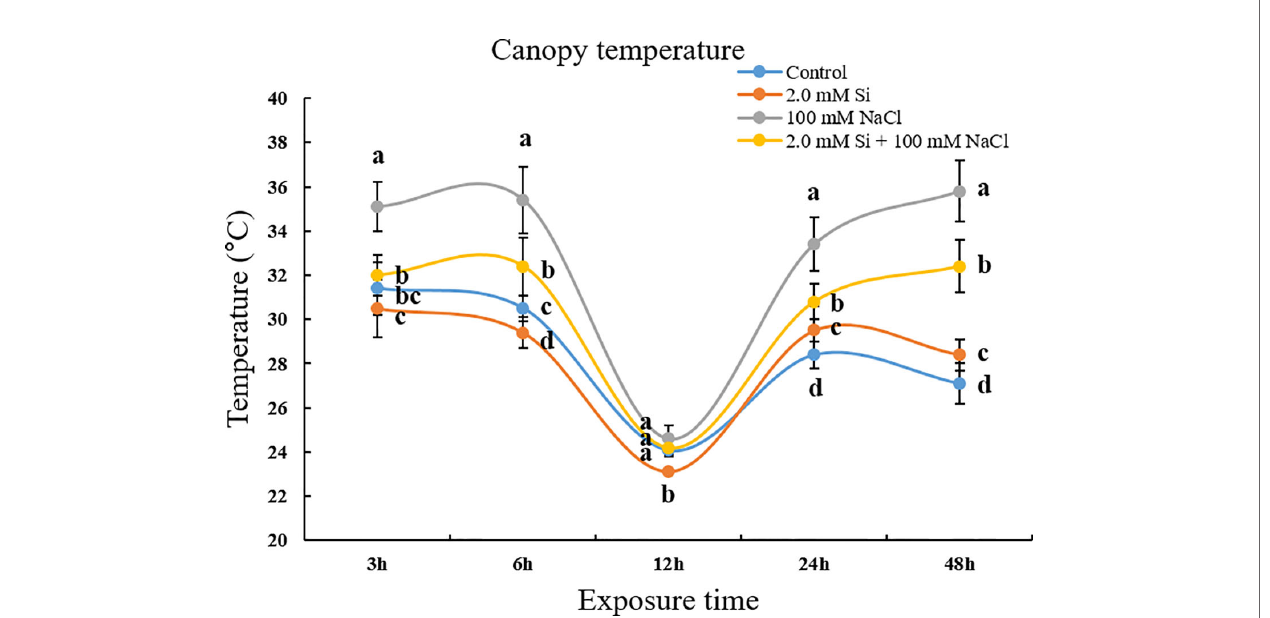
FIGURE 1 | Canopy temperature after single or combined Si and NaCl treatments in soybean plants. Data were collected at 3, 6, 12, 24, and 48 h after stress exposure. Temperature data were calculated by an average temperature of the selected 20 spots on soybean leaves per treatment. In the fi gure, error bars denote standard deviation, and different letters near error bars indicate signi fi cant differences by Duncan's multiple range test ( P < 0.05). Data were collected in triplicate and are presented as the average ± standard error ( n =